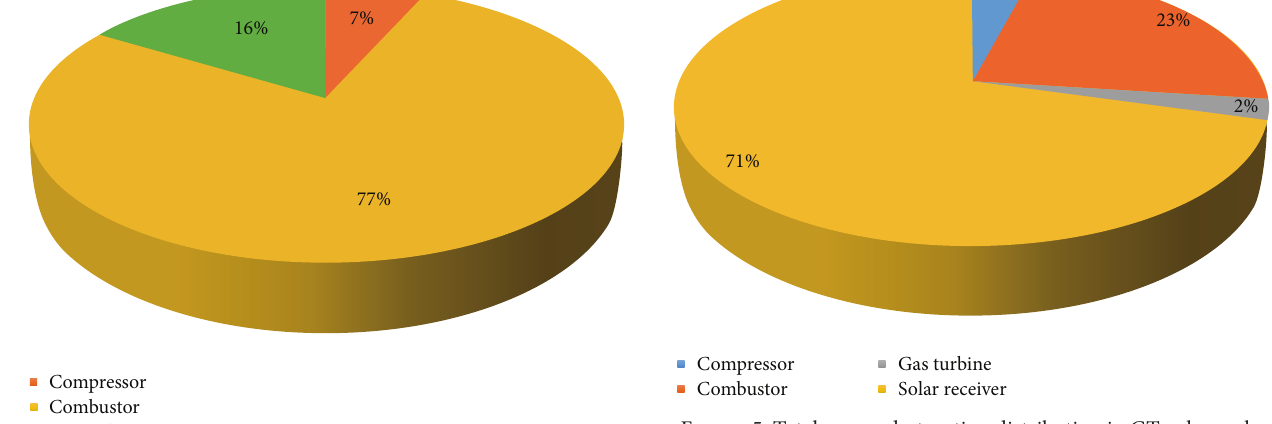
Figure 5: Total exergy destruction distribution in GT-solar